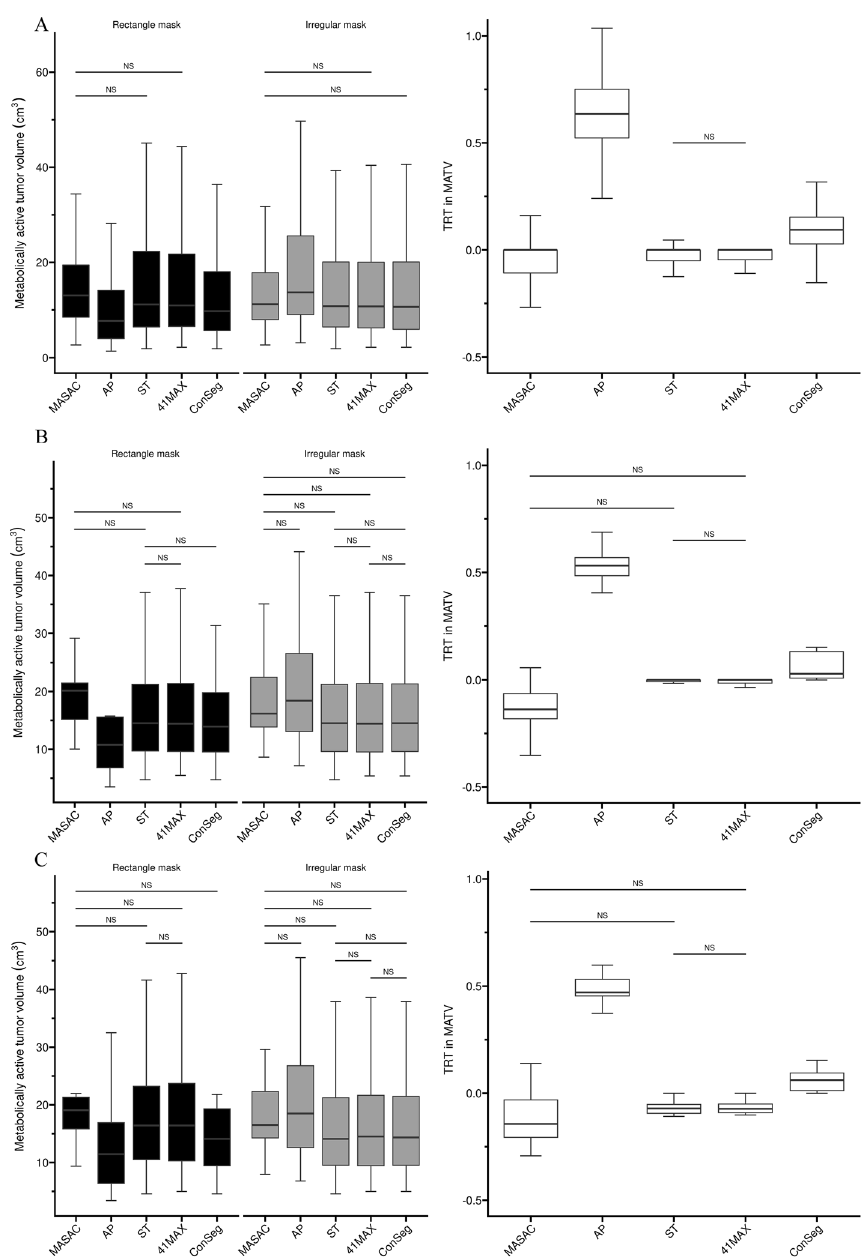
Fig. 3 Box-and-whisker plots of MATV and TRT MATV for each method in clinical database ( A ) and anthropomorphic simulation with ( B ) and without C respiratory motion. For display purposes, outliers identified as 1.5*interquartile range were removed from plot (whiskers). Comparisons without statistically significant differences are marked with horizontal